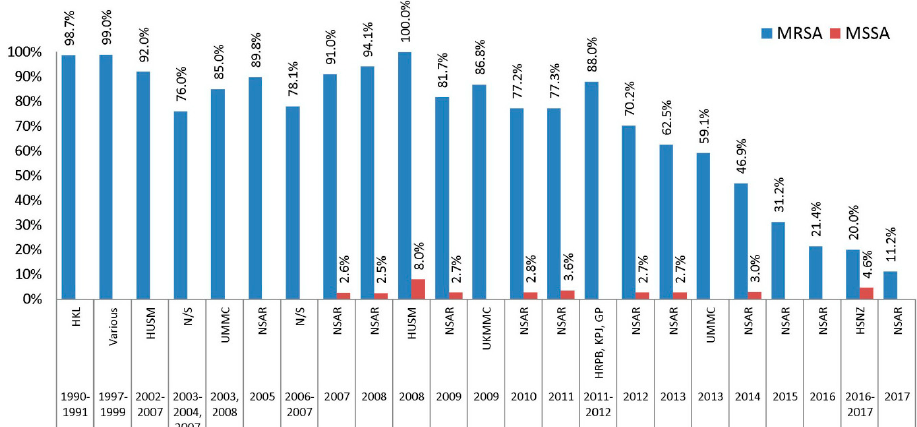
Figure 1. The prevalence of gentamicin resistance among Malaysian S. aureus isolates, 1990–2017. Data from the National Surveillance of Antibiotic Resistance (NSAR) reports, 2003–2005 [24], 2007